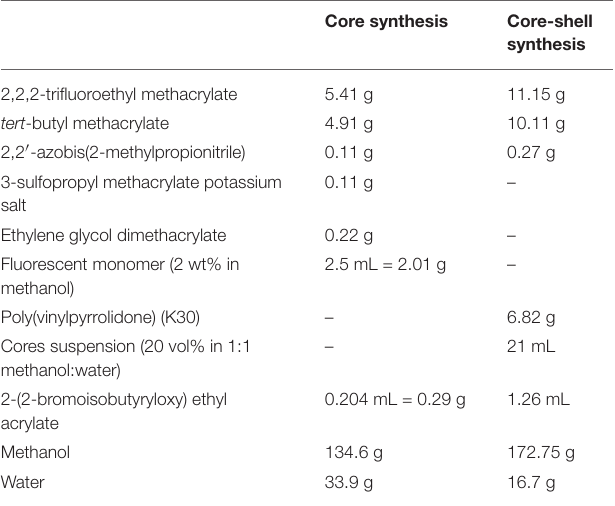
TABLE 1 | Mass/volume of each component added to the synthesis of the core particles and core-shell